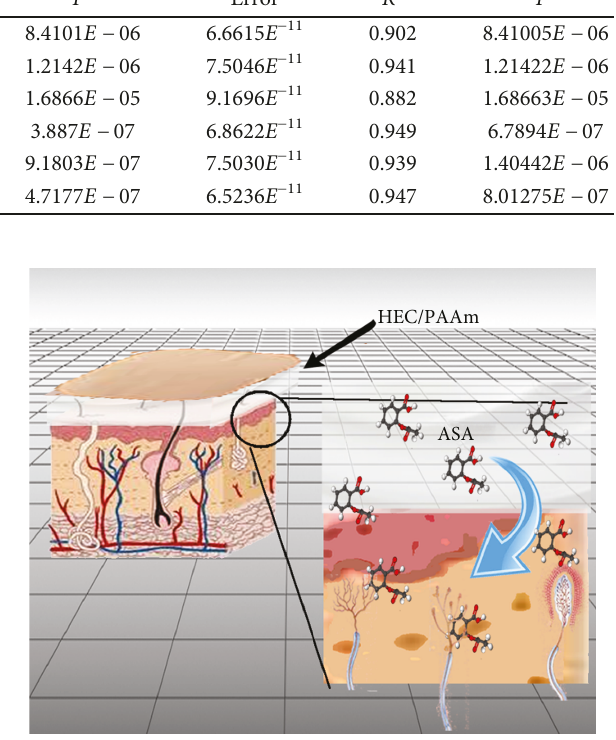
Figure 9: Schematic representation of ASA of the hydrogel entering the